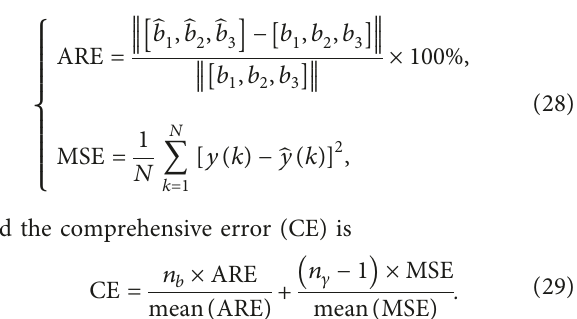
Figure 3: Order of the linear block using AIC.